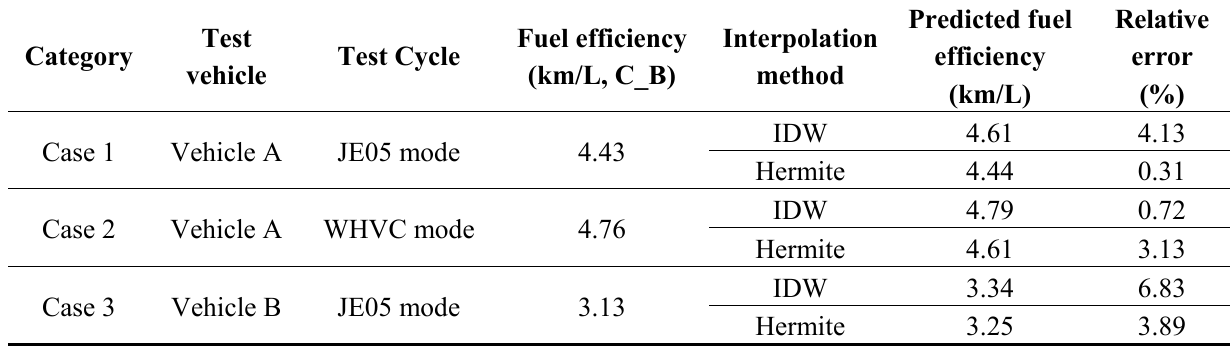
Table 7. Predicted fuel efficiency results and relative error between simulation and test.